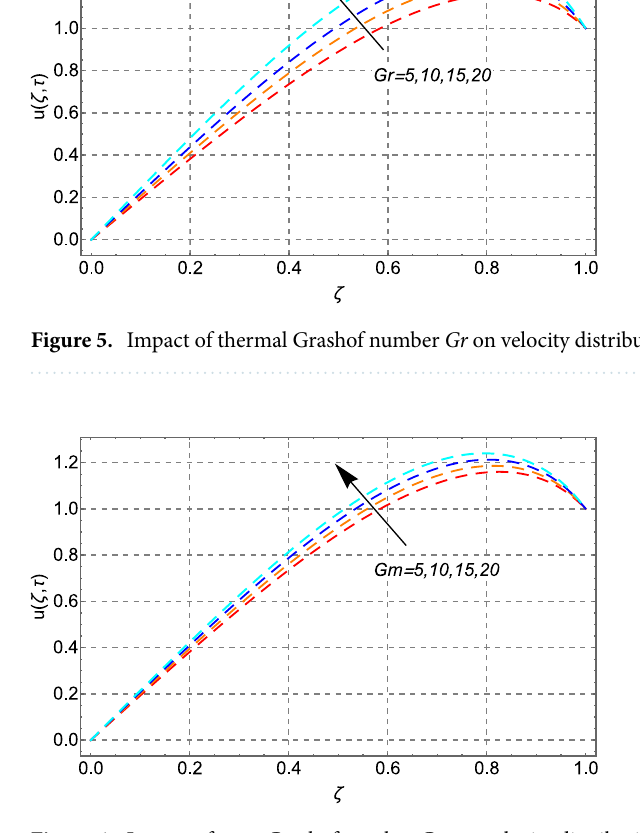
Figure 6. Impact of mass Grashof number Gm on velocity